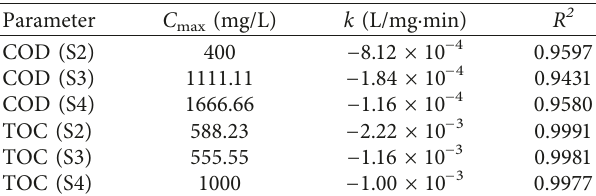
Table 3: Coefficients of pseudosecond-order kinetic model with Al